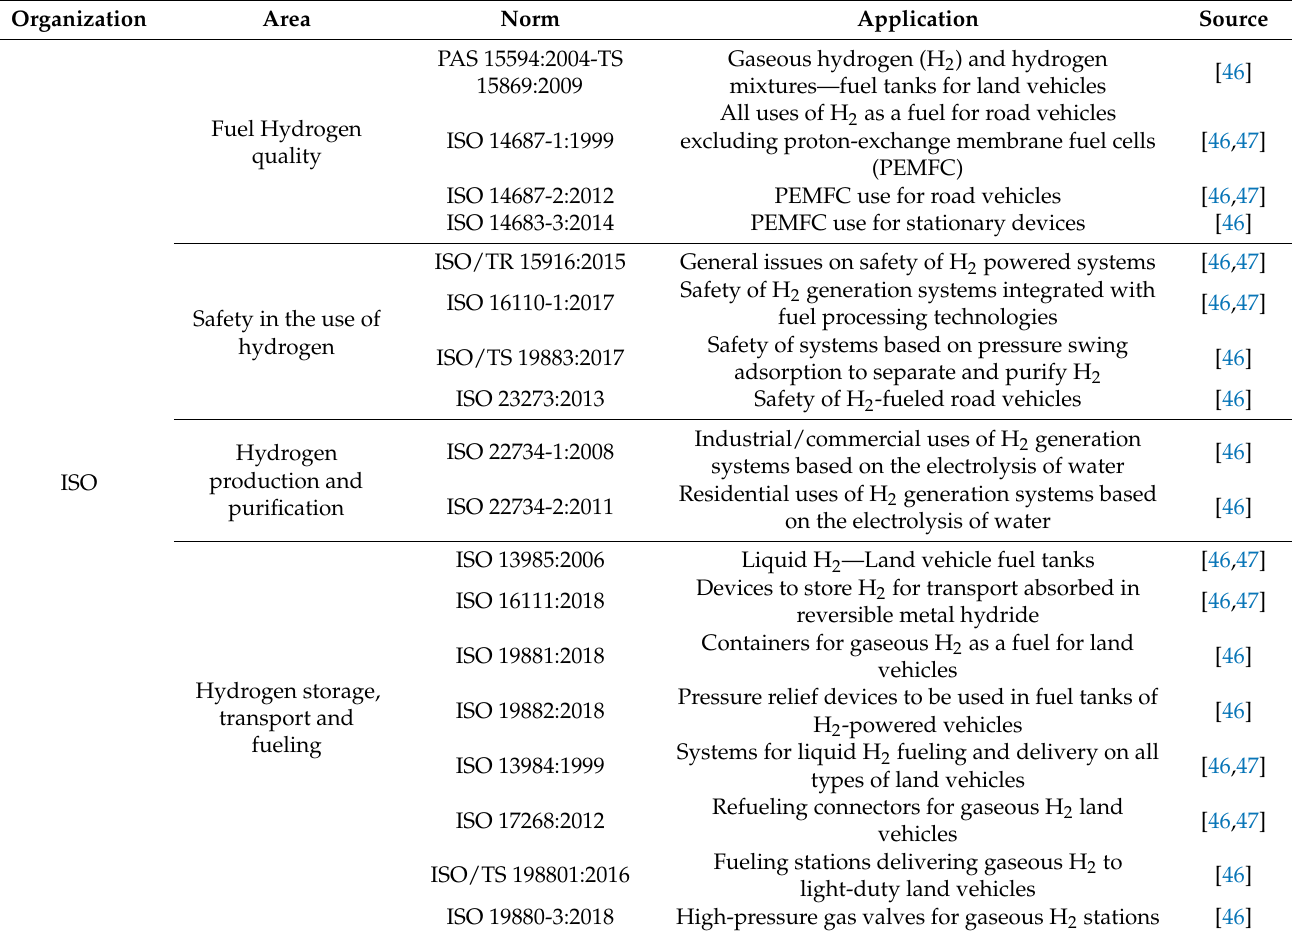
Table 3. Global standardization norms of the International Organization for Standardization (ISO) and International Electrotechnical Commission (IEC) for the use of hydrogen as a